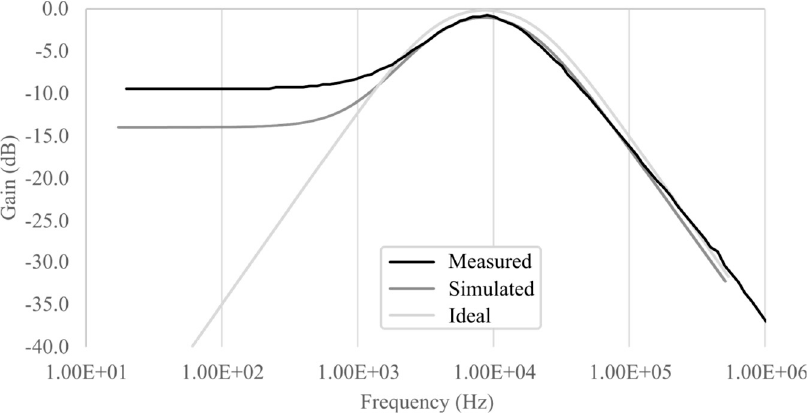
Figure 21. Experimental, simulation and ideal gain responses versus frequency.